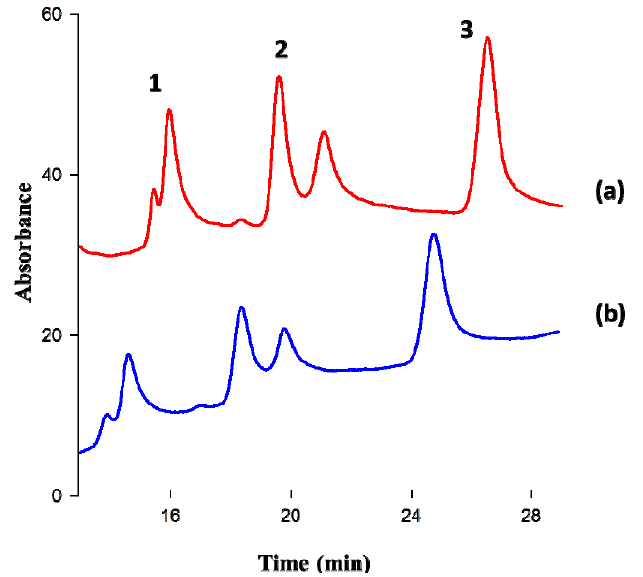
Figure 3. Chromatogram obtained with the magnetic capillary column in the Magnetic-IT-SPME device coupled with Cap-LC-DAD (230 nm); ( 1 ) simazine; ( 2 ) atrazine; and ( 3 ) terbutylazine. ( a ) Applying magnetic field B = 150 G, reverse polarity); ( b ) Without magnetic field ( B = 0 G). Injection ( B desorption 85:15, flow 6 μ L min − 1